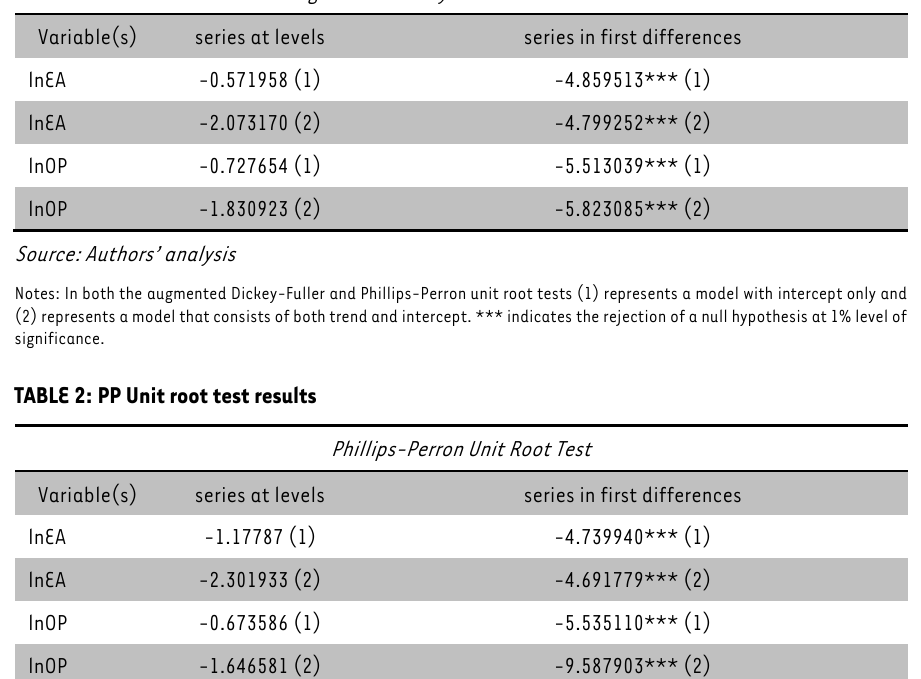
TABLE 1: ADF Unit root test results